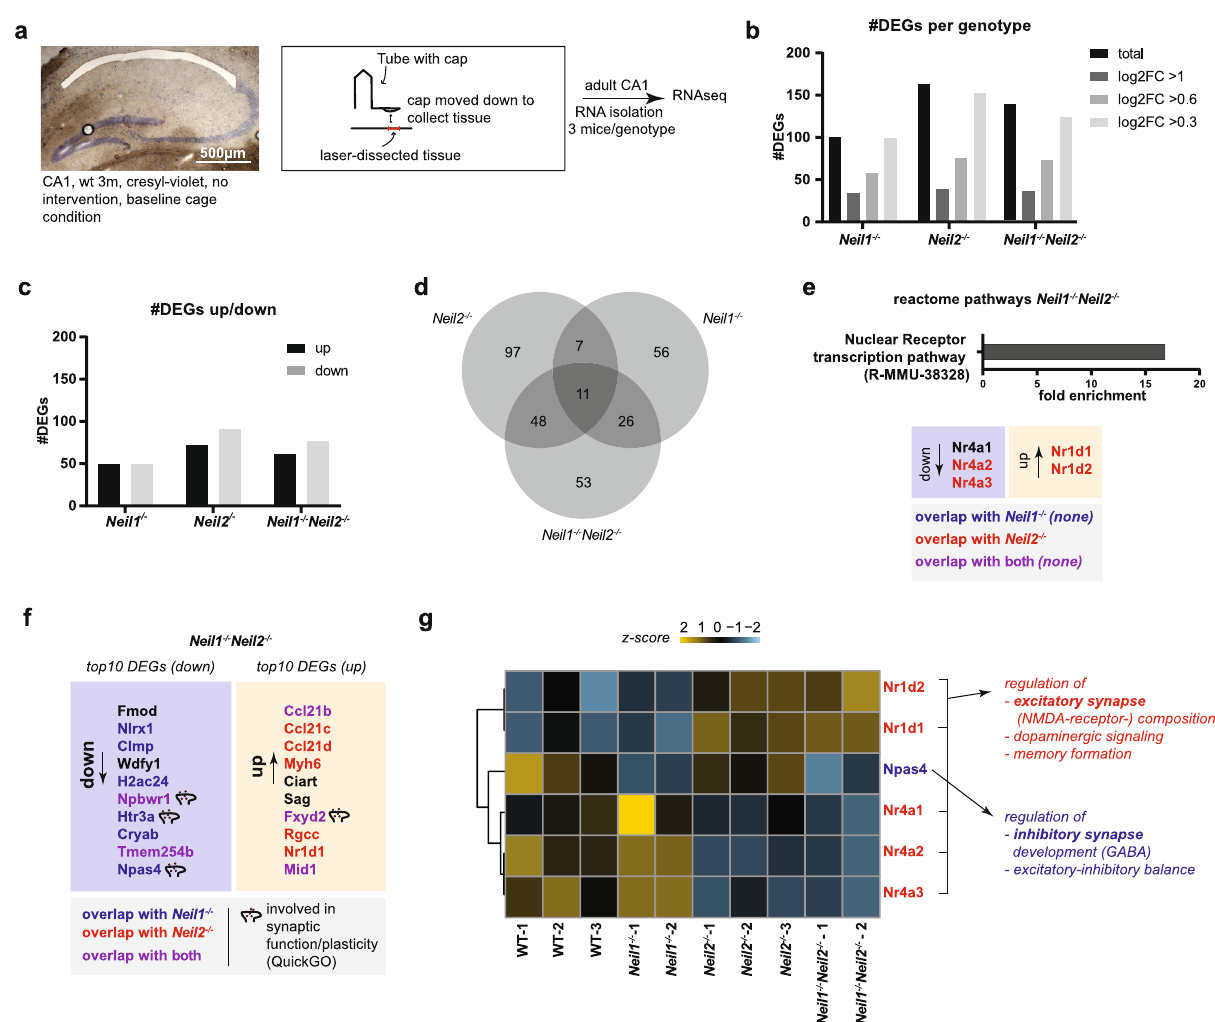
Fig. 4 NEIL1 and NEIL2 jointly affect the CA1 transcriptome. a Tissue used for RNAseq was isolated using a laser dissection approach (see Methods for details). b Amount of DEGs found for each genotype (based on pooled data from three (WT and Neil2 − / − ) or two ( Neil1 − / − and Neil1 − / − Neil2 − / − ) mice, see also Supplementary Fig. 3). DEGs above each log2fold cut-off are displayed in different shades of grey. c Up- and downregulated genes for each mutant. d Overlapping DEGs between single and double knockouts. e Enriched reactome-pathway, R-MMU-38328 (fold enrichment 19.72, FDR 1.19e-02), and corresponding DEGs in Neil1 − / − Neil2 − / − mice. Overlap with Neil1 − / − or Neil2 − / − mice is indicated. f top10 down- and upregulated DEGs in Neil1 − / − Neil2 − / − mice. (Npas4: − 1.12 log2fold). Overlap with Neil1 − / − or Neil2 − / − mice is indicated. g Expression of relevant DEGs at a single animal level (z-score table based on FPKMs). Thematic relevance of DEGs in Neil1 − / − Neil2 − / − mice is shown to the